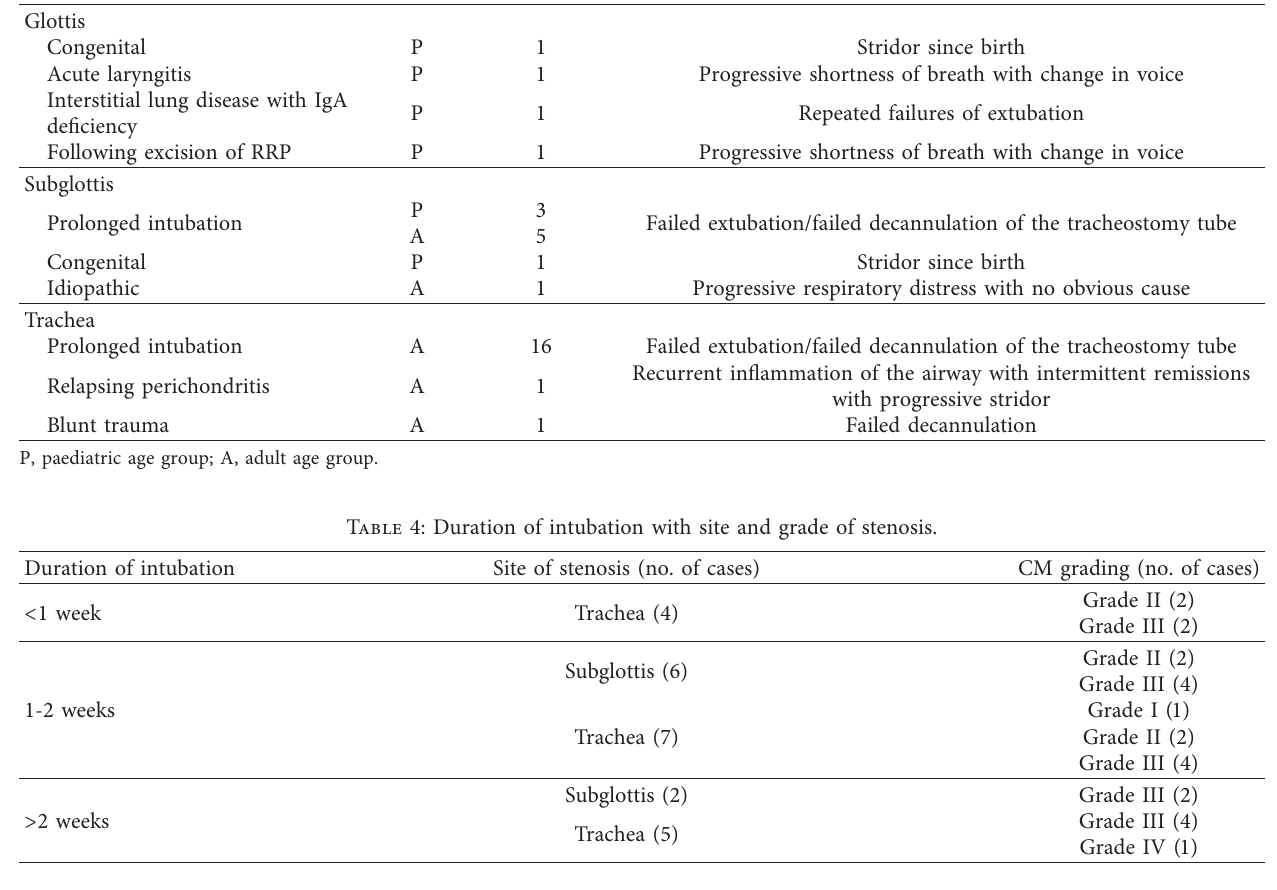
Table 5: Correlation between duration of intubation and severity of